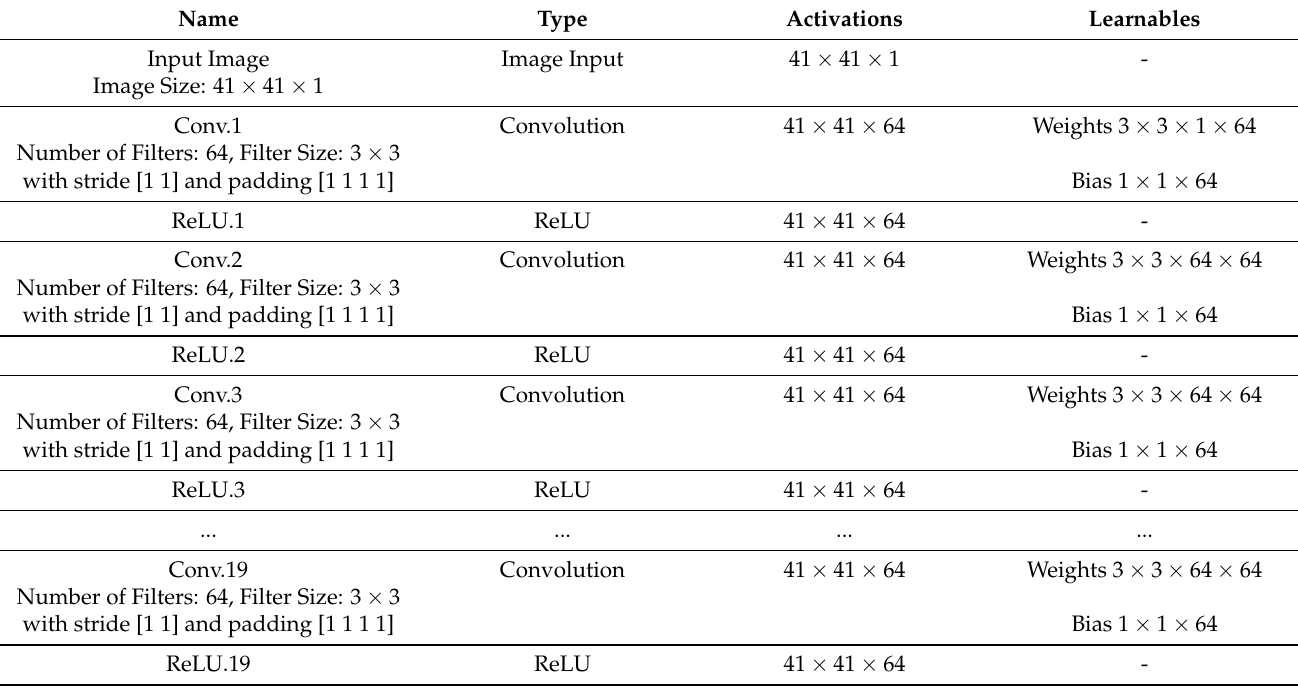
Table 2. Detailed structural parameters of